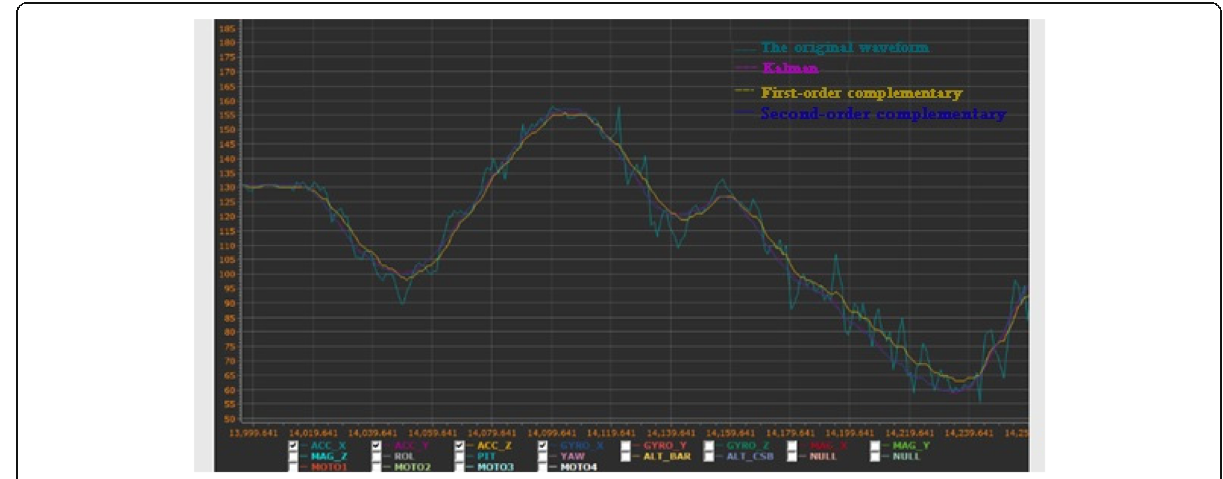
Fig. 38 First-order low-pass filtering waveform